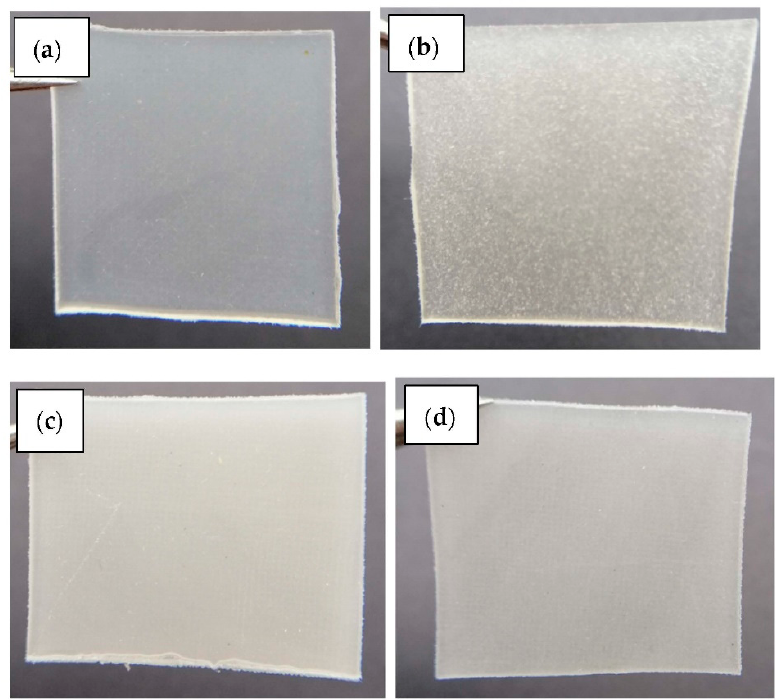
Figure 12. Images of ( a ) PEVAc, ( b ) PEVAc/RD, ( c ) PEVAc/DNP, and ( d ) PEVAc/NP-DNP.